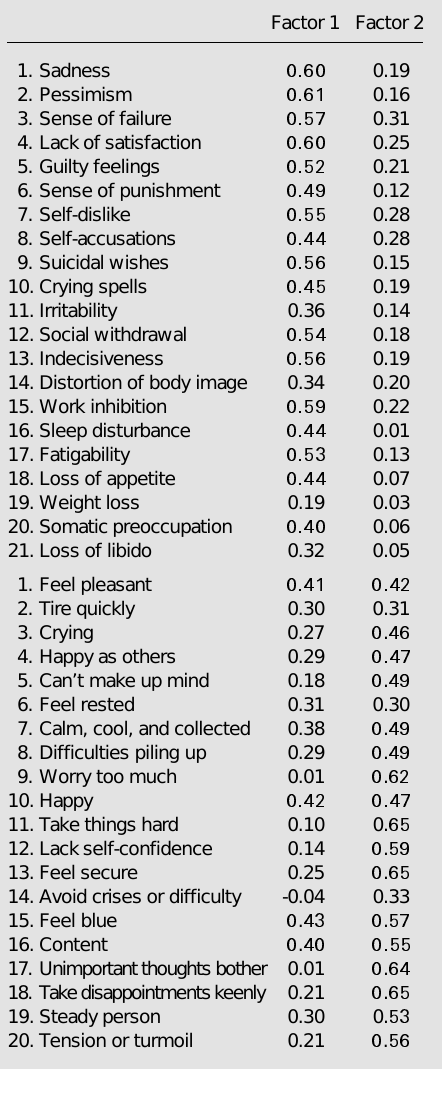
Table 4 - Factor analysis for the combination of the 41 items of the Beck Depression Inventory and State-Trait Anxiety Inventory (trait form) scales. Only loadings above 0.40 (bold) were considered to significantly contribute to a